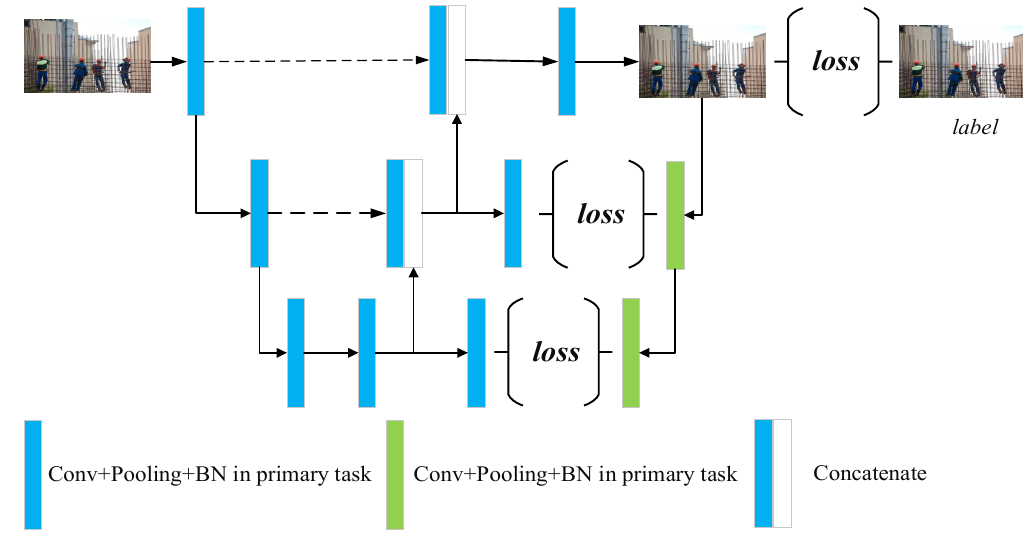
Figure 3. The architecture details of the SR module .